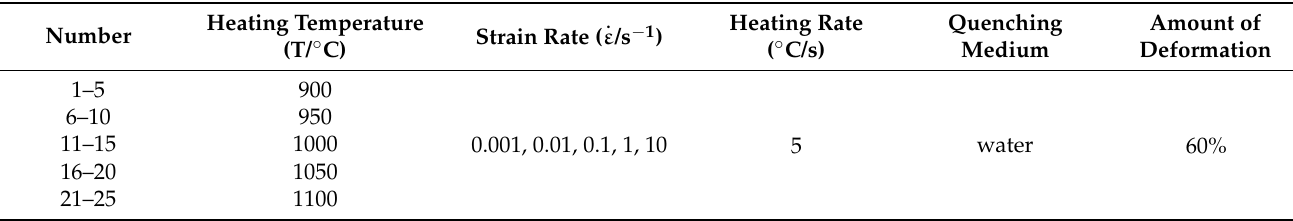
Table 2. Parameters used in isothermal compression